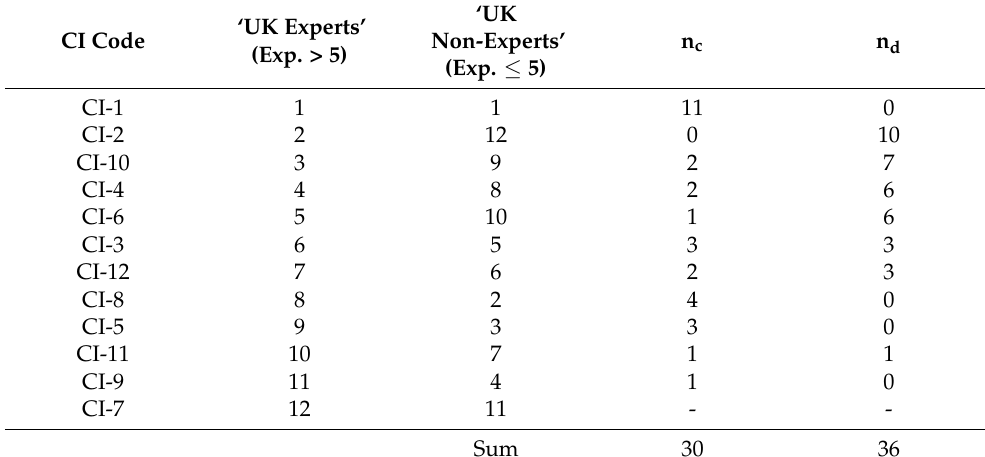
Table 10. Kendall’s-tau coefficient of concordance for CIs level. ‘UK CI Code